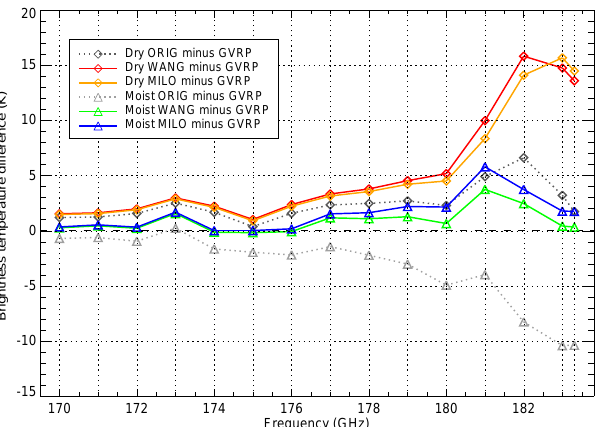
Figure 6. Median MonoRTM minus GVRP spectral residuals, where the MonoRTM was driven by WANG- and MILO-corrected radiosondes (red/green and blue/brown, respectively) and uncor- rected radiosondes (gray lines). These median residuals were com- puted for the moistest and driest 30% of the CJC radiosondes, as shown in Fig. 4.